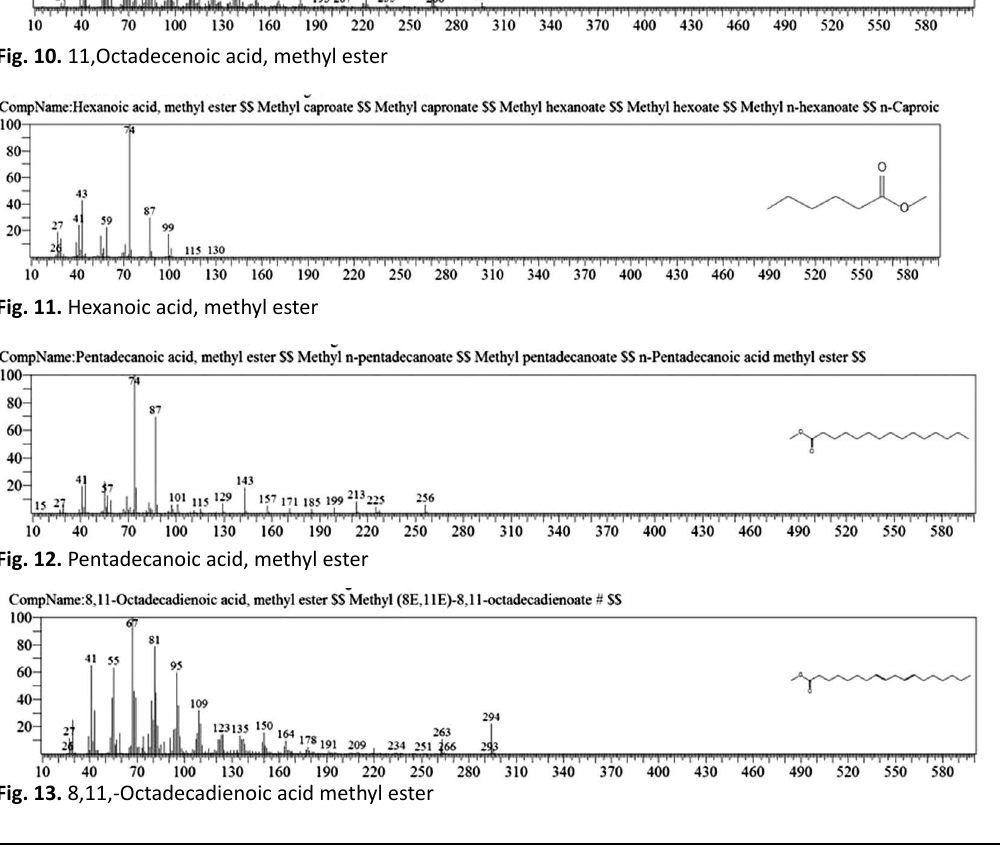
Fig. 10. 11,Octadecenoic acid, methyl ester